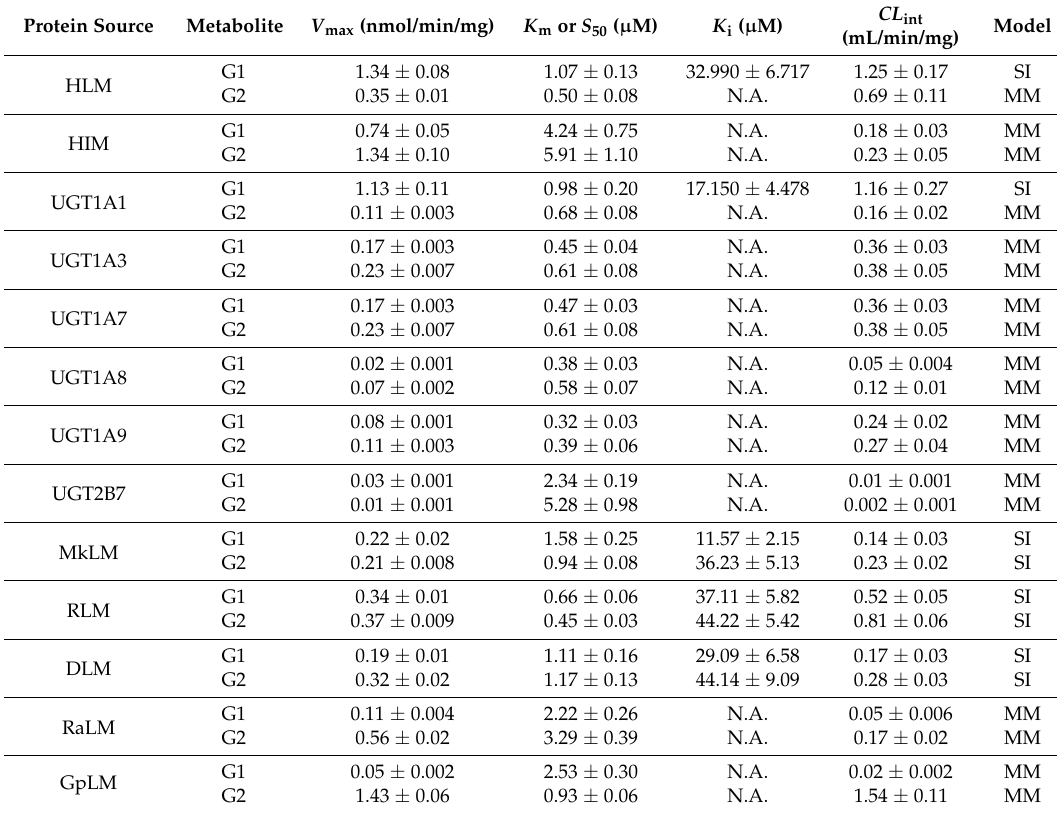
Figure 2. Kinetic profiles for glucuronidation of wushanicaritin by various types of microsomes. ( a ) Pooled human liver microsomes (HLM); ( b ) pooled human intestine microsomes (HIM); ( c ) expressed UGT1A1; ( d ) expressed UGT1A3; ( e ) expressed UGT1A7; ( f ) expressed UGT1A8; ( g ) expressed UGT1A9; ( h ) expressed UGT2B7; in each panel, the insert figure shows the corresponding Eadie–Hofstee plot. All experiments were performed in triplicate. Data are expressed as the mean ± SD. G1: wushanicaritin-3- O -glucuronide; G2: wushanicaritin-7- O -glucuronide. Table 1. Kinetic parameters of wushanicaritin glucuronidation by HLM, HIM and expressed UGT enzymes (mean ± SD). All experiments were performed in triplicate.